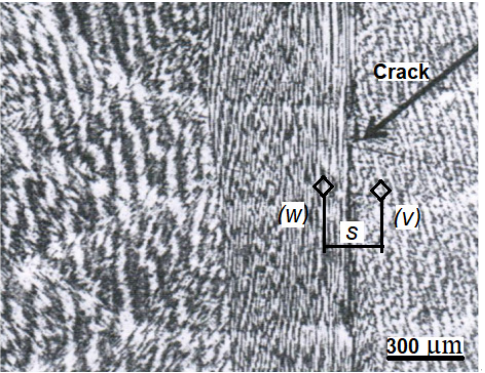
) ) ; ( w )—with concentrations ( c w ; s is at at L L